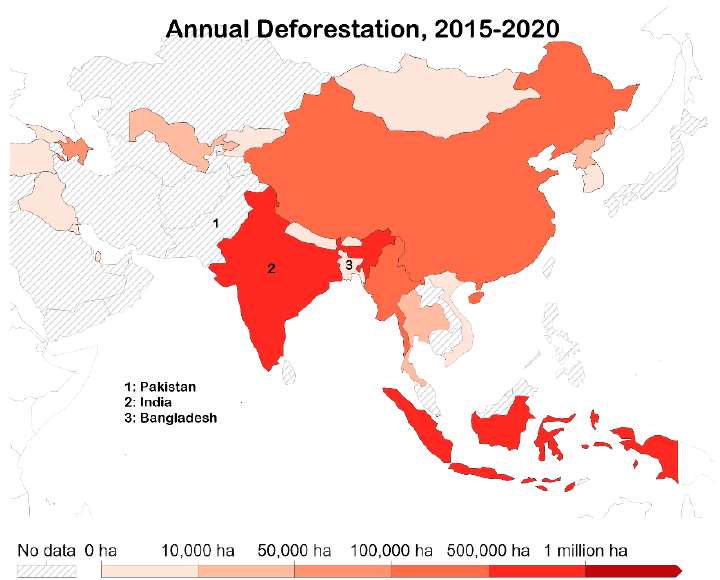
Figure 5. Annual deforestation between 2015–2020 in the South Asian region [46].